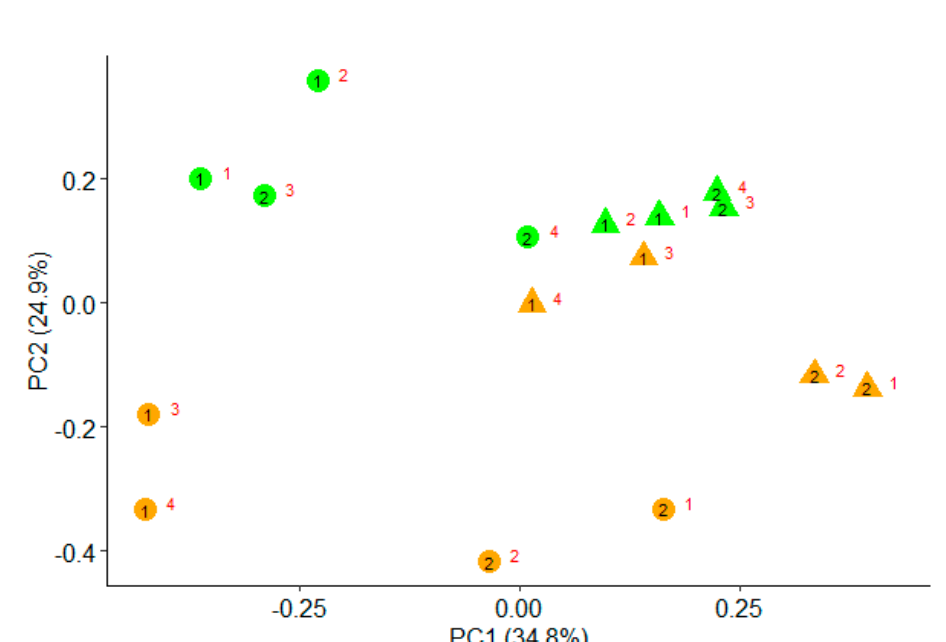
Figure 1. Principal coordinate analysis (PCoA) based on the Bray–Curtis dissimilarities of the automated ribosomal intergenic spacer analysis (ARISA) profiles from liquid (circles) and solid (triangles) phase of fermenters fed a diet containing either extruded maize (green) or dried citrus pulp (orange). Black numbers (1 and 2) correspond to incubation run, and red numbers (1, 2, 3, and 4) to an individual Rusitec fermenter.